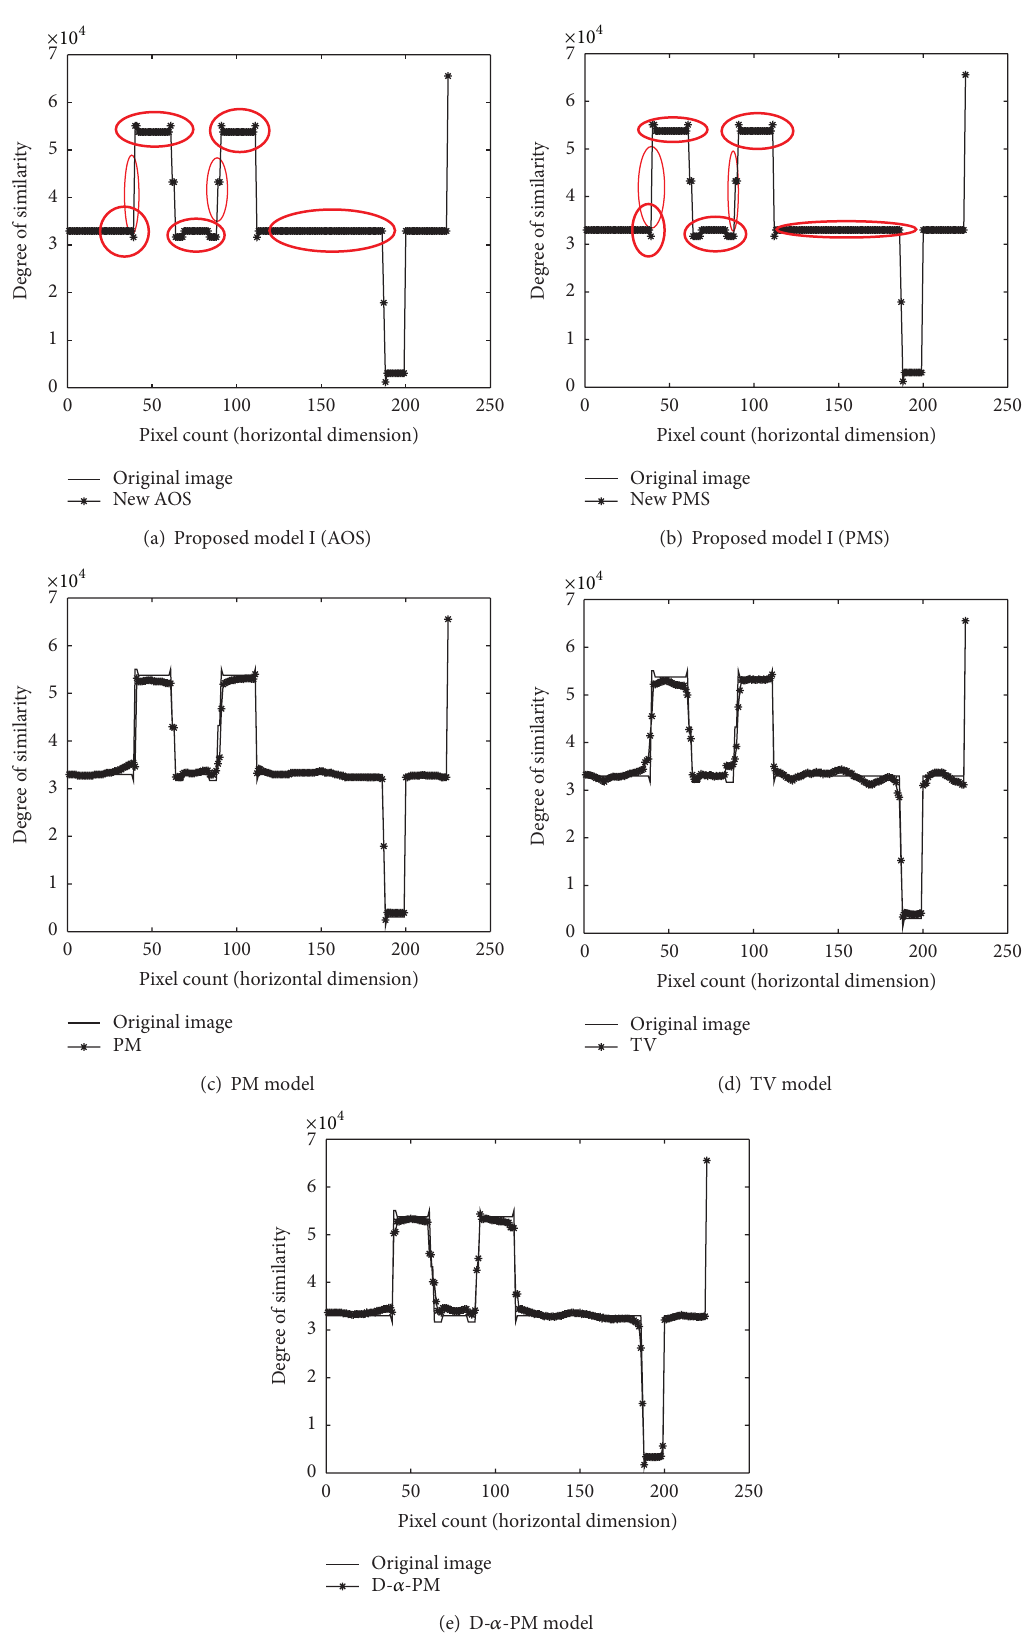
Figure 2: Synthetic image ( 300×300 ). Similarity graphs between the original image and results of our method (AOS and PMS), PM method, TV method, and D- 𝛼 -PM method,